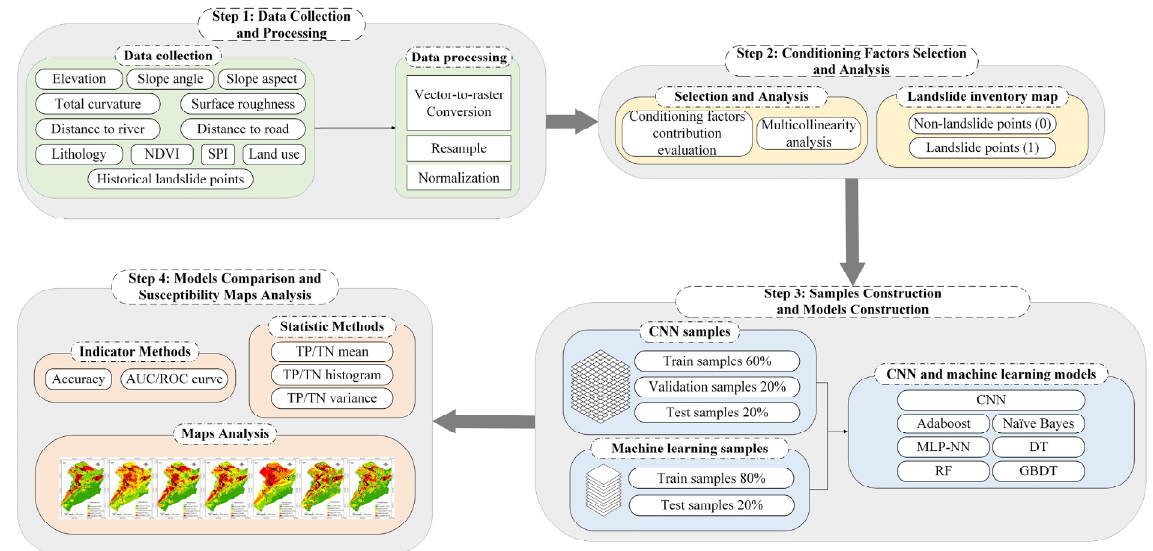
Figure 3. Workflow of the landslide susceptibility assessment.